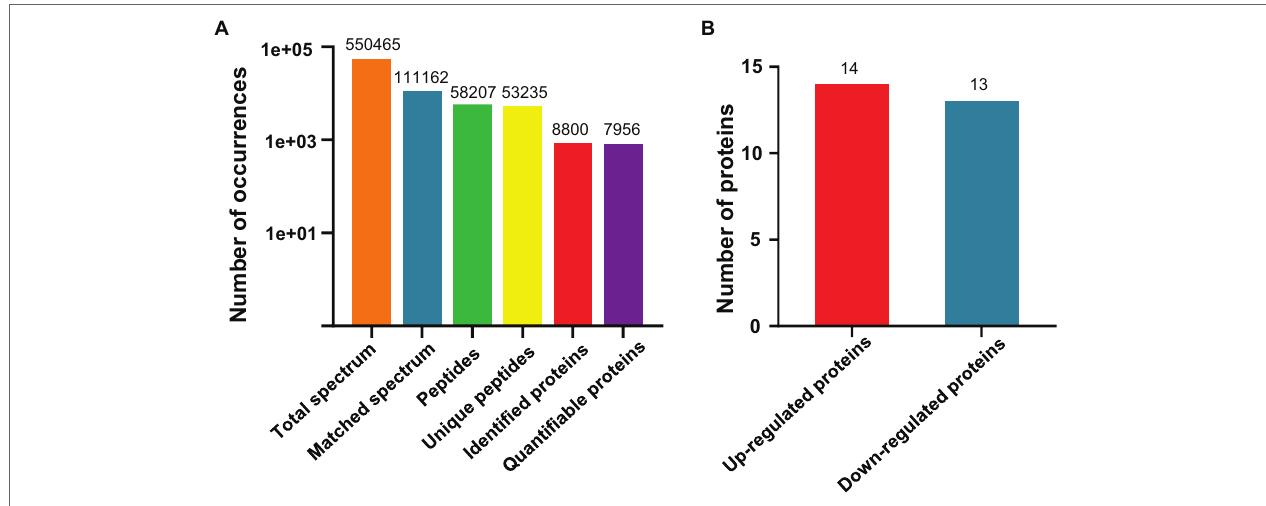
FIGURE 2 | Quantitative proteomic study on thermo-responsiveness in Arabidopsis . Two-day-old Arabidopsis wild-type plants were treated at 22 ° C or 29 ° C for 3 h and etiolated tissues were sampled for TMT (Tandem Mass Tags)-based quantitative proteomic analysis. Basic information on proteomics was shown in (A) and the number of differentially expressed proteins was shown in (B)